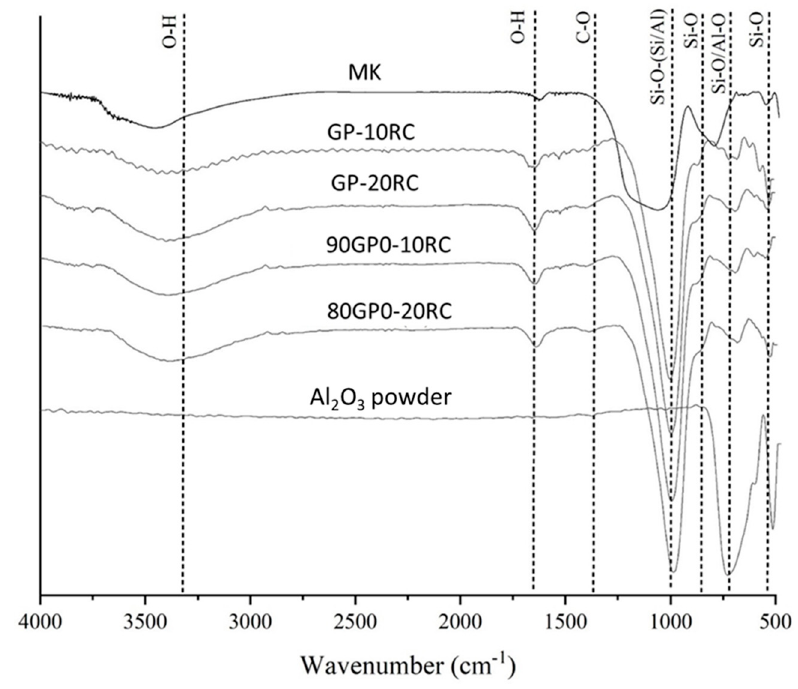
Figure 2. FT-IR spectra of MK powder, all geopolymers with Al 2 O 3 , and Al 2 O 3 powder. Table 2. List of vibrations of aluminosilicates and corundum in the FT-IR range. Wavenumber (cm − 1 )